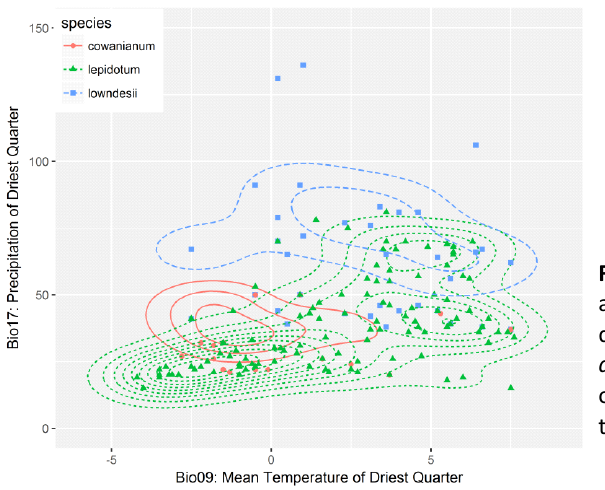
Figure 3. 2 - Dimensional niche plot between mean temper- ature of the driest quarter (bio09) and precipitation of the driest quarter (bio17) for all three sister taxa ( R. cowani- anum , R. lowndesii and R. lepidotum ). It depicts higher overlap of R. lepidotum climatic niche with R. cowanianum than with R. lowndesii